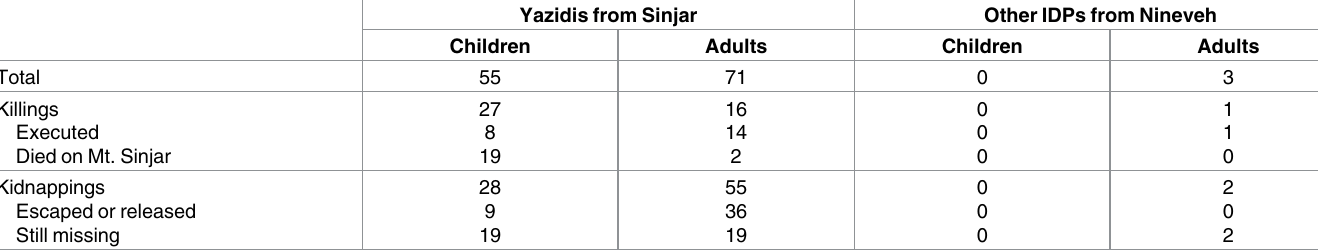
Table 2. Reported killings and kidnappings of children (0–14) and adults (15+) in the sample.